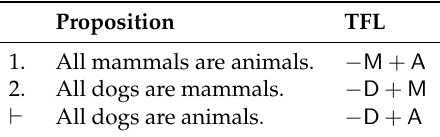
Table 3. A valid syllogism: aaa